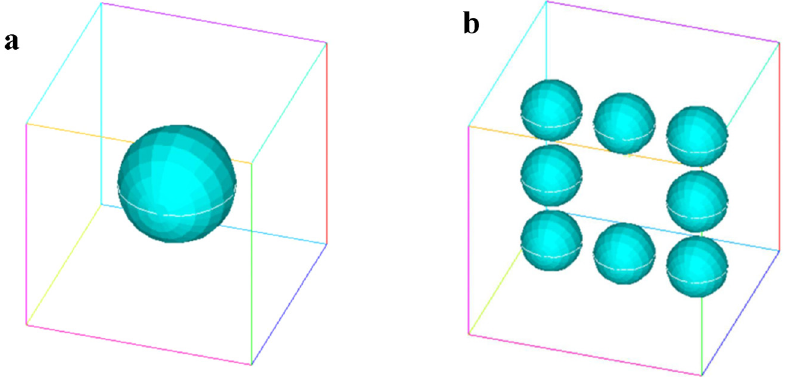
Figure 7: The cells are modeled as the spheres with two fi xed diameters in two ideal cubes: ( a ) r = 2 mm and ( b ) r = 1